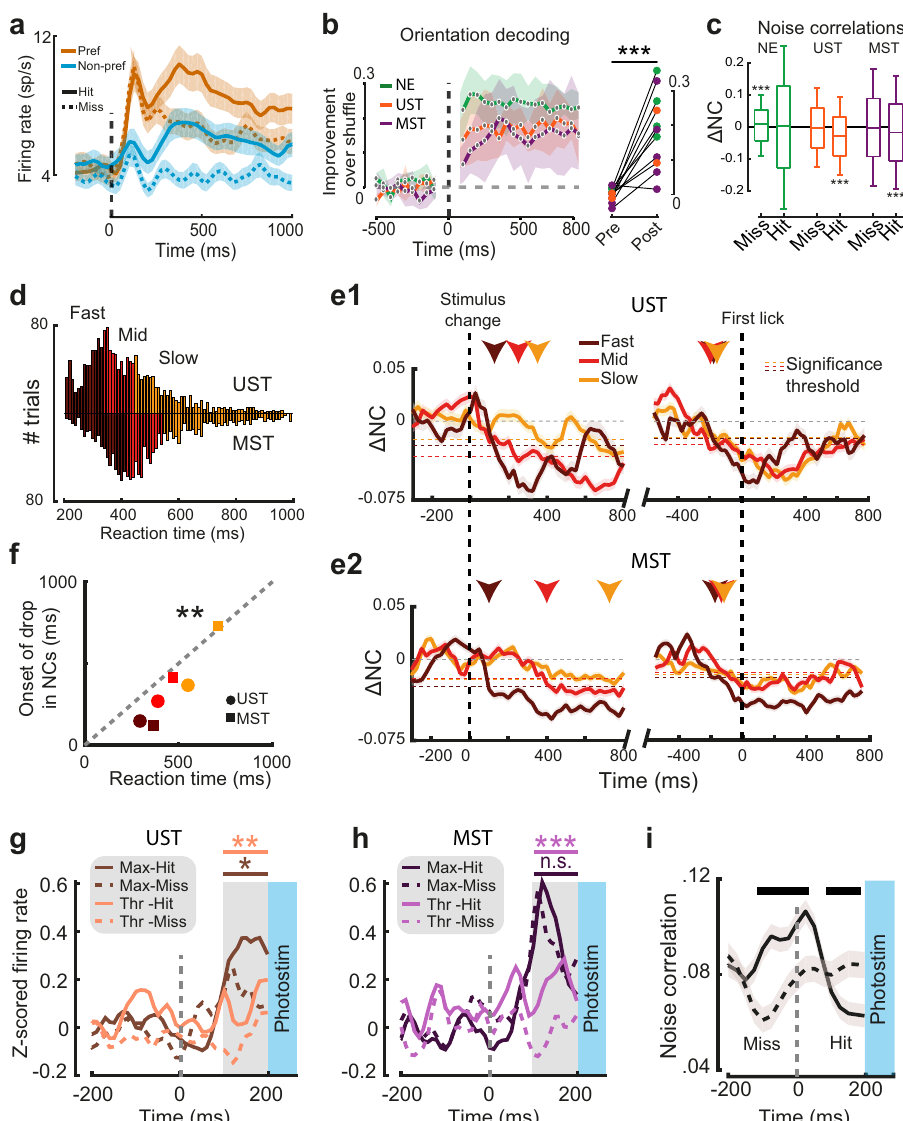
Fig. 7 Onset of report-related activity in task A and drop in noise correlations predict effects of late silencing. a Average spiking rate for all orientation- selective neurons for preferred and non-preferred orientations is split by hits and misses (UST and MST neurons combined; task A). b Orientation decoding performance over time. Right panel: decoding performance increased post-stim (0 to + 500 ms) versus pre-stim ( − 500 to 0 ms; n = 11 sessions, cohorts combined, ANOVA, F (1,17) = 44.76, p = 4.1 × 10 − 6 ) and increased in individual sessions from all cohorts (colored dots). c Change in noise correlation (NC) relative to baseline (200 to 1000 ms compared to baseline − 500 to 0 ms) for visual trials split by choice and cohort (for auditory trials, see Supplementary Fig. 9a). Boxplots show the median and interquartile range (box limits) and 0.5 × interquartile range (whiskers). Noise correlations decreased only during hits in UST and MST mice (ANOVA, UST, n = 1930 pairs, F (1,3856) = 82.44, p < 1 × 10 − 19 ; MST n = 13972, F (1,28188) = 142.96, p < 1 × 10 − 33 ). Misses in NE mice were associated with a slight increase in noise correlations ( n = 2904 pairs, F (1,5805) = 14.67, p < 0.001). d Reaction time distributions for visual hits in UST and MST cohorts and tertile ranges. e1 Noise correlations over time with respect to baseline, either aligned to stimulus change (left) or fi rst lick (right). Horizontal dashed lines indicate for each tertile the threshold for each tertile for the onset of the drop in NCs (below 2 standard deviations of the baseline; − 500 to 0 ms) and this onset is highlighted with colored arrows. Note how noise correlations (aligned to stimulus change) drop fi rst in fast trials, and progressively later in medium and slow trials. Right panels show that, when aligning to lick onset, the drop in noise correlations precedes reaction times by a similar lag, independent of reaction time tertile. e2 Same as e1 , but for MST mice. f Reaction time and moment of decorrelation were signi fi cantly correlated (Pearson correlation, n = 6, r = 0.960, p = 0.002). Scatterplot shows median reaction time and earliest time point of decorrelation for each tertile in the two visually trained cohorts. g Average Z-scored fi ring rates just before photostimulation (100 – 200 ms) were higher if the trial resulted in a visual hit rather than a miss in UST mice (Thr: F (1,156) = 10.16, p = 0.002; Max: F (1,152) = 5.66, p = 0.019; ANOVA). h Same as g , but for MST mice. Firing rates just before photostimulation were higher for hits than misses only for threshold visual changes ( F (1,268) = 13.19, p = 0.001), but not maximal changes ( F (1,254) = 0.59, p = 0.44). i Noise correlations for visual hit and miss trials before photostimulation onset (grouped across UST and MST cohorts and saliency levels). Black bar on top indicates time bins with signi fi cantly different NCs between hits and misses ( p < 0.05). Throughout the fi gure, lines and shading are mean ±